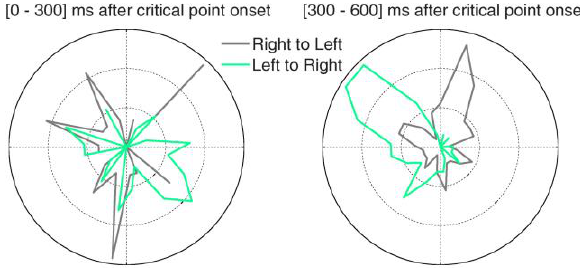
Figure 6. Polar histograms for microsaccades during the critical period, as the coin was moving. Green: trials where the coin moved from left to right. Grey: trials where the coin moved from right to